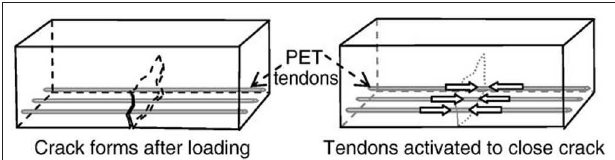
FIGURE 2 | Self-healing of a concrete induced by shrinkage of PET tendons with shape-memory capability. Figure reproduced from Jefferson et al. (2010), with permission from